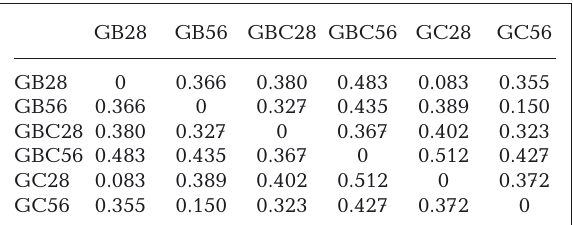
3. Distance matrix based on weighted UniFrac. Row and column headers represent treatment and day combi- nations (see Fig. 6)